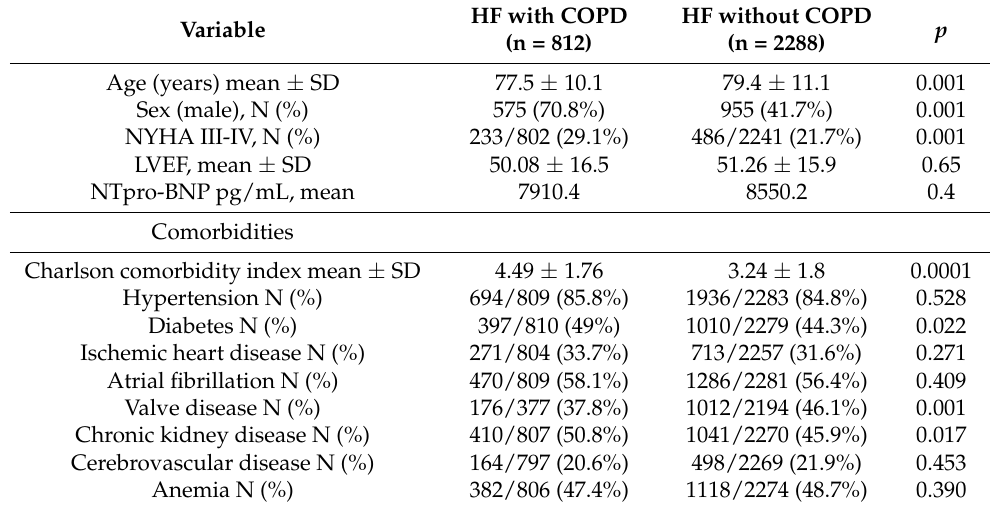
Table 1. Clinical characteristics of patients with HF with/without history of COPD.